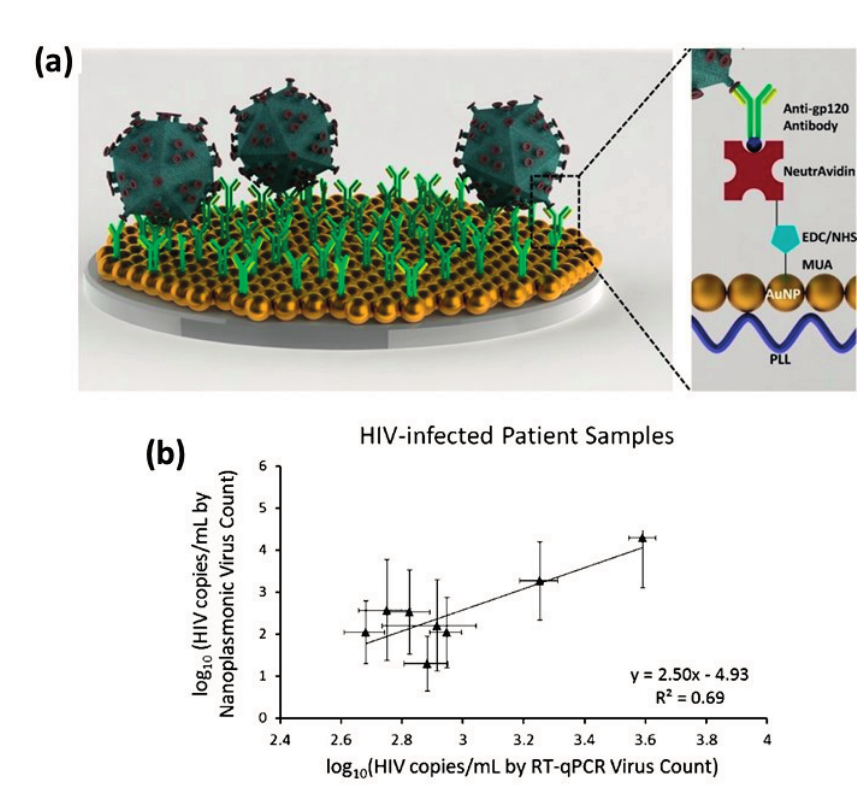
Figure 6. ( a ) An HIV detection assay is depicted which relies on carbodiimide chemistry to cover the surface with antibodies specific for HIV subtypes; ( b ) The plasmonic system can detect and distinguish between HIV subtypes A, B, C, D, E, G in patients with HIV [136]. Another disease that has a large effect on the livelihood of people in the developing world is